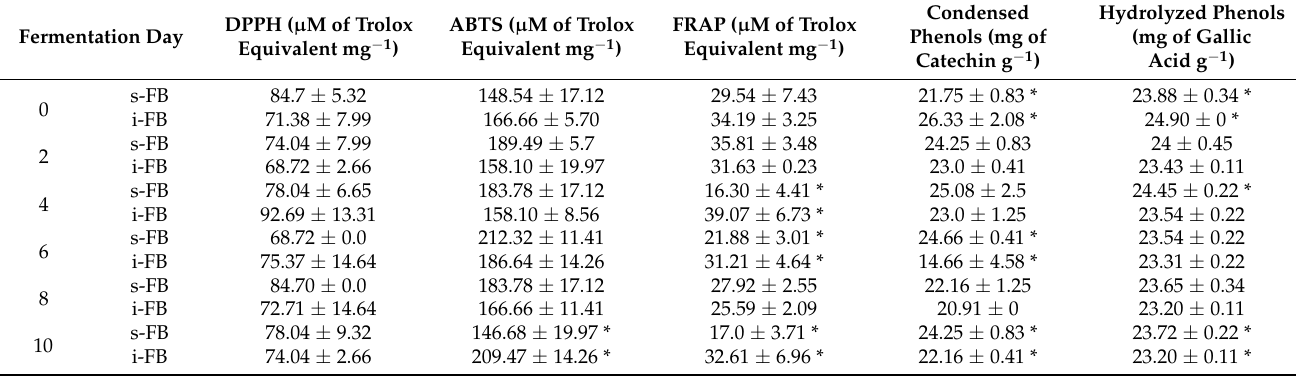
Figure 4. Quantification of I3C in fermented broccoli. s-FB: spontaneous fermentation; i-FB: induced fermentation (co-culture). *: significant difference ( p < 0.05). Table 2. Antioxidant activities and phenolic compound contents of fermented